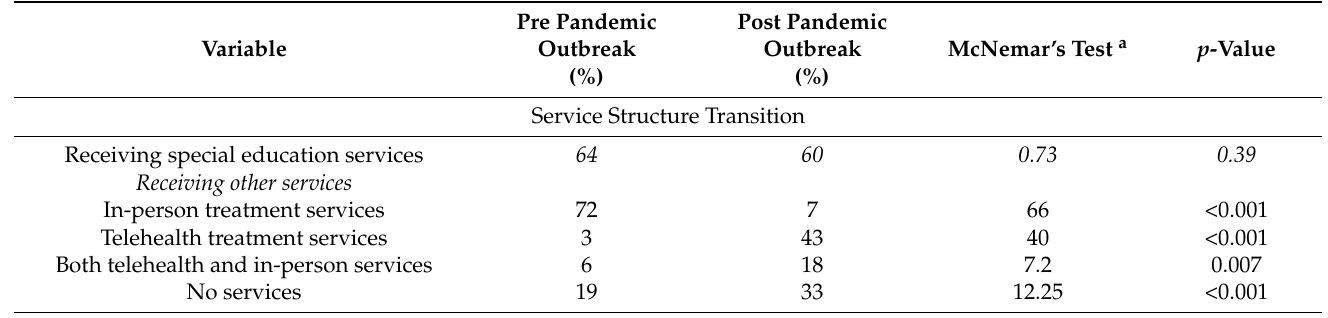
Table 1. Service changes for children with developmental disabilities before and after the pandemic outbreak ( n =